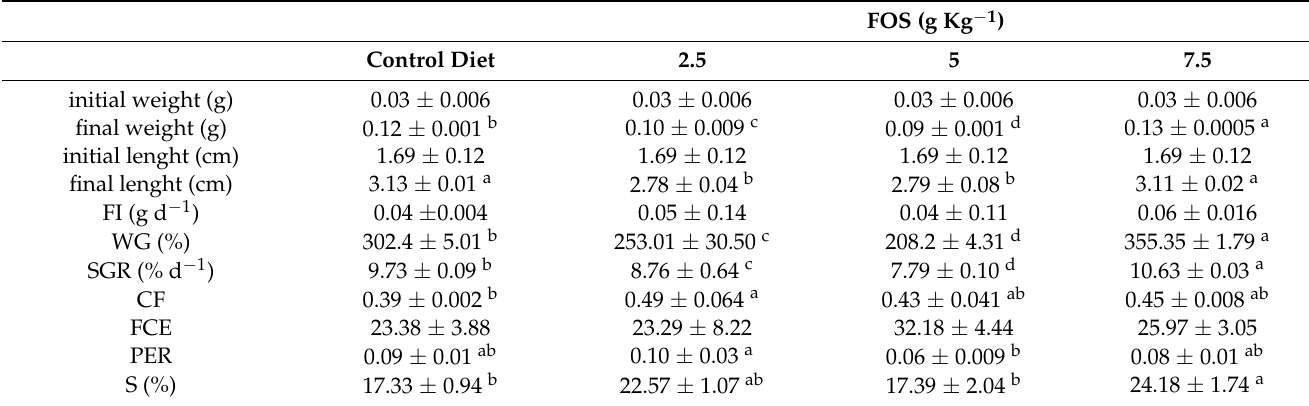
Table 3. Growth indexes and survival rate (mean ± standard deviation, SD) of A. tropicus larvae fed with a diet supplemented with different levels of FOS (2.5, 5, and 7.5 g kg − 1 ) and a diet without FOS (control diet) for 15